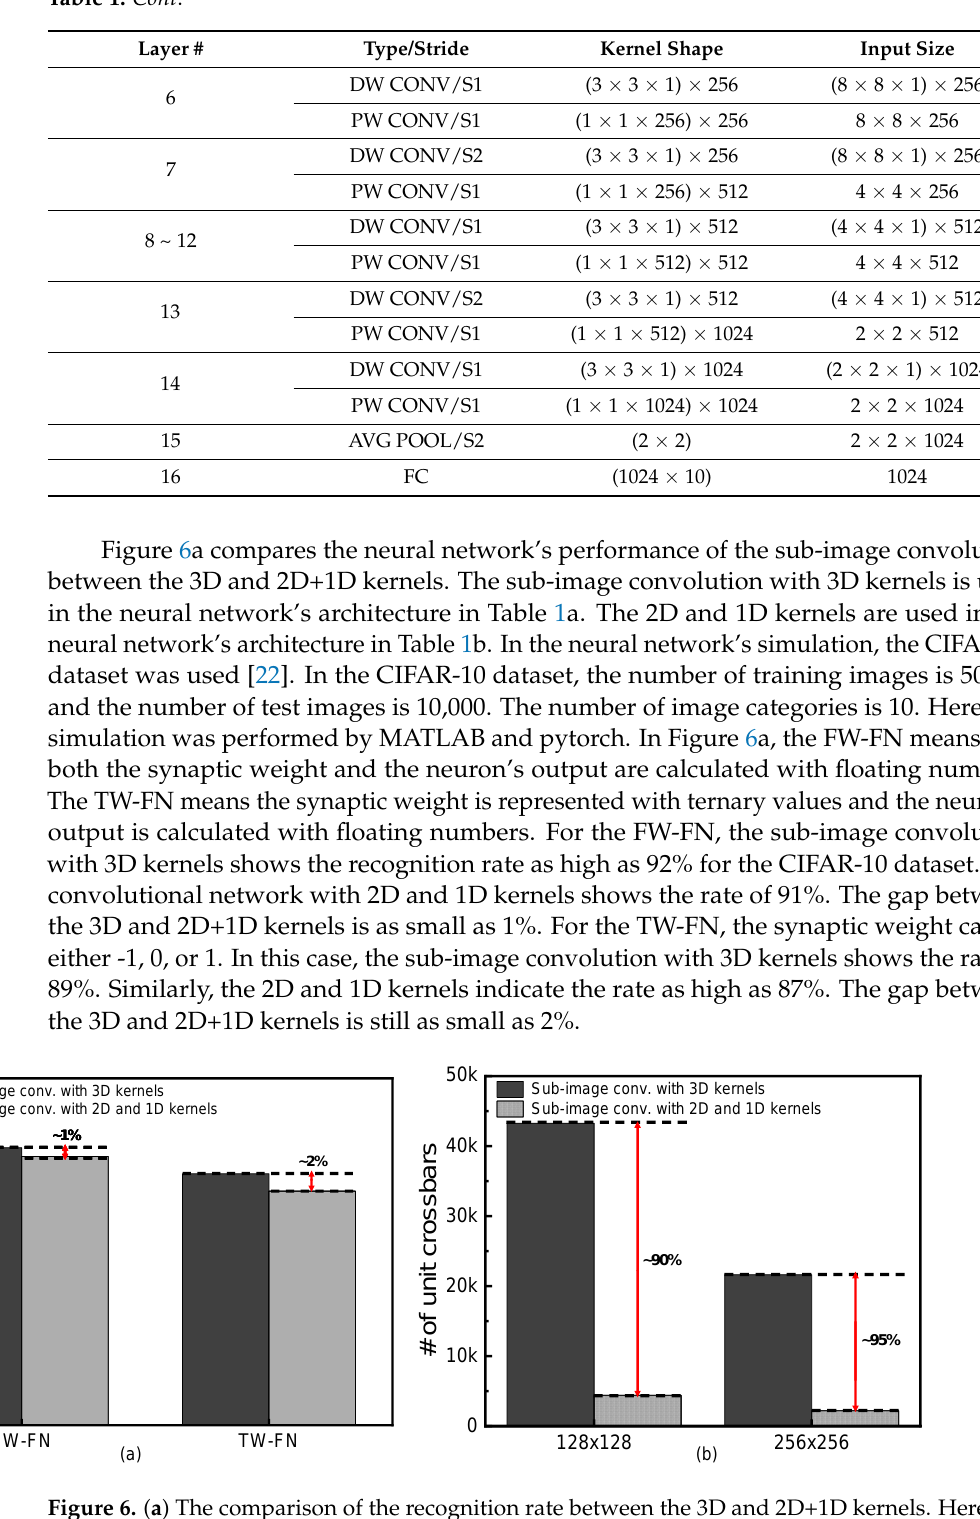
Figure 6. ( a ) The comparison of the recognition rate between the 3D and 2D+1D kernels. Here, the FW-FN means the floating-point weights and floating-point neurons used in the simulation. The TW-FN means the ternary weights and floating-point neurons. ( b ) The comparison of the number of unit crossbars used in the sub-image convolution between the 3D and 2D+1D kernels. Here, the unit crossbar’s size is assumed to be 128 × 128 and 256 × 256.